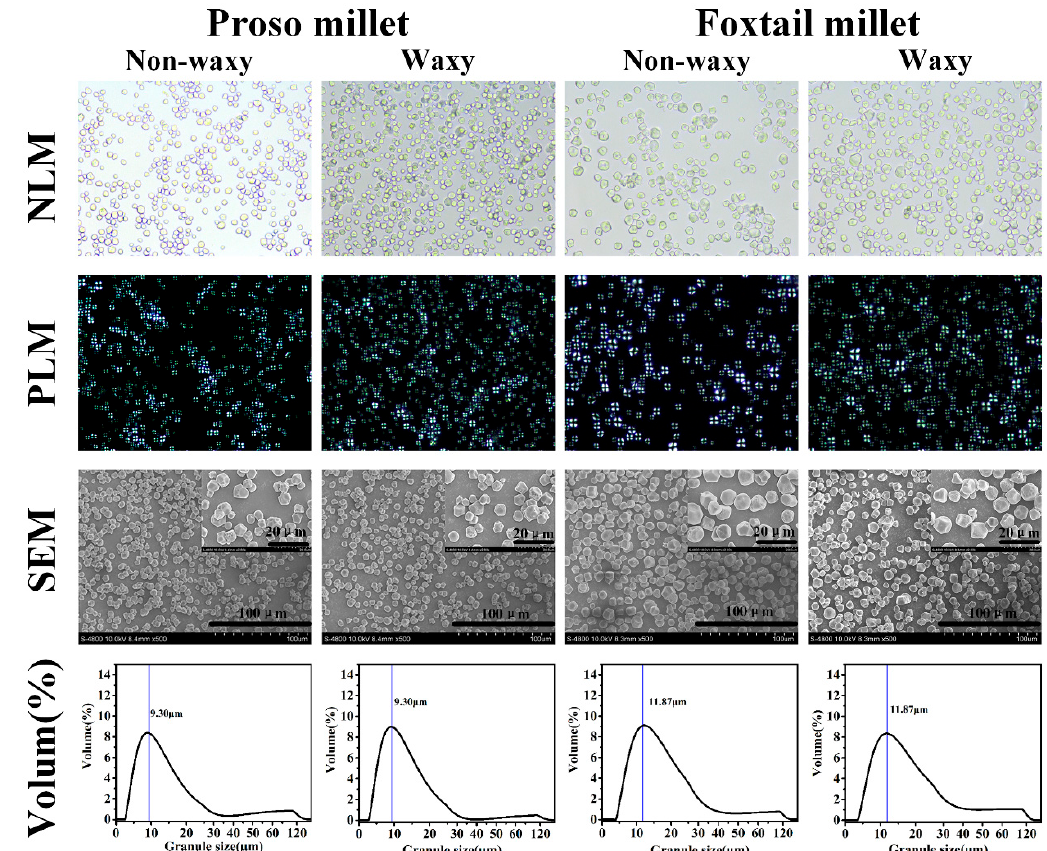
Figure 1. Morphologies of starch granules under normal light microscope (NLM), polarized light microscope (PLM), and scanning electron microscope (SEM), and the granule size distribution of starches.